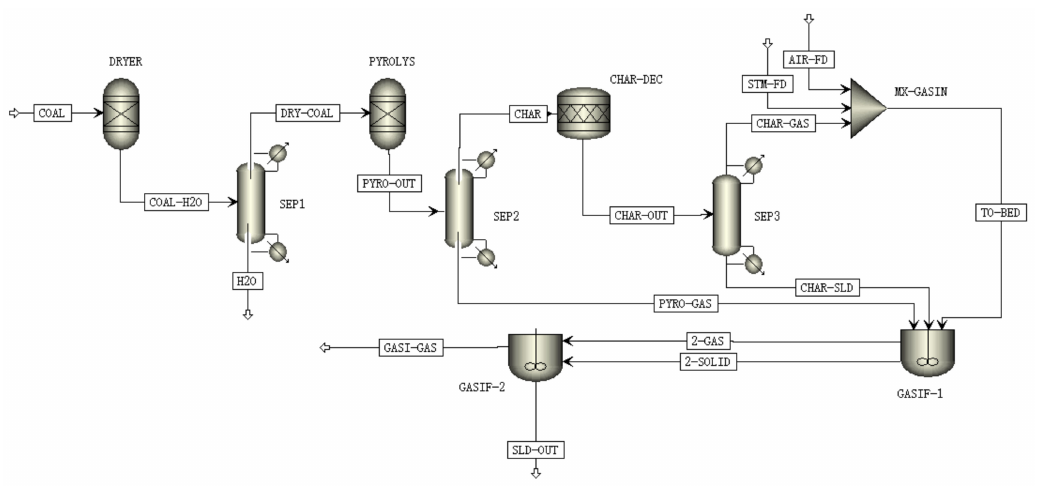
Figure 2. Flowsheet of the gasification process in Aspen